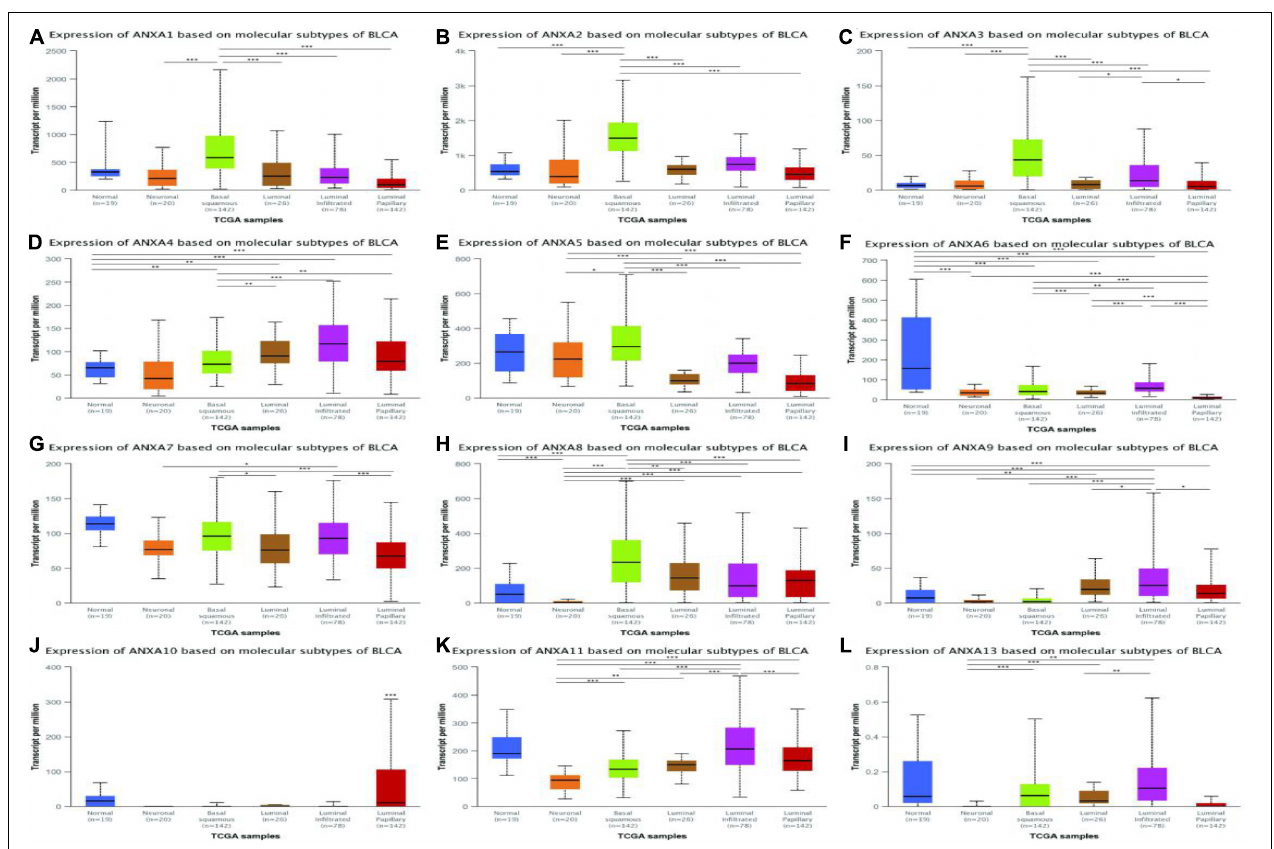
FIGURE 5 | Correlation between the mRNA expression of different ANXA members and molecular subtypes of MIBC patients in UALCAN database. The mRNA expression of ANXA family members in normal individuals or in MIBC patients in five subtypes (A–L) . (* p < 0.05; ** p < 0.01; *** p <